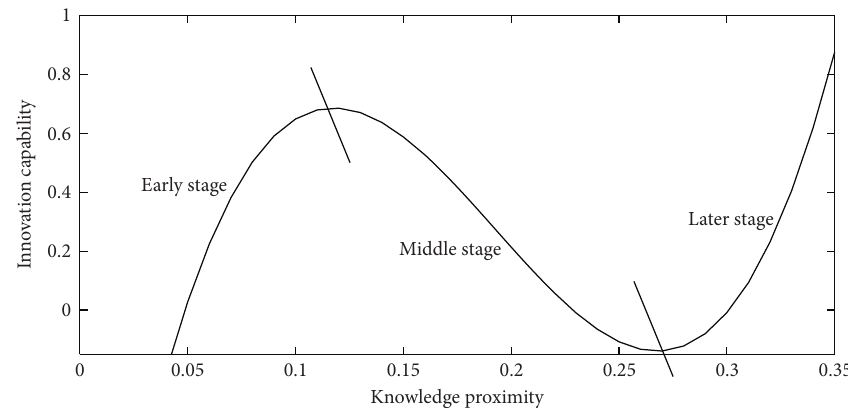
Figure 8: Effect of knowledge proximity and innovation